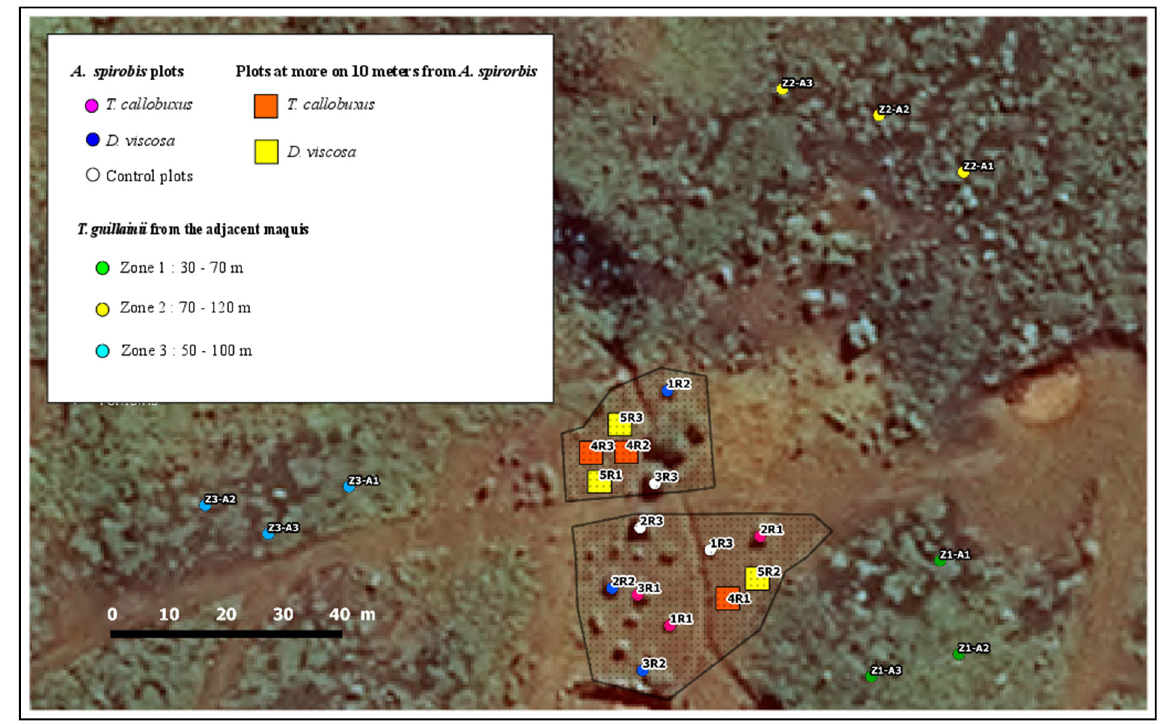
Figure 1. View of plantation site and surrounding area on the Koniambo Massif, New Caledonia. Plantation plots are located inside areas surrounded by black lines. The circles inside planting areas represent plots planted in a radius around A. spirorbis (see Figure 2a). The squares represent plots at least 10 m away from A. spirorbis (see Figure 2b). The circles outside planting areas are the exact positioning of harvested T. guillainii trees in the natural maquis surrounding the planting areas.